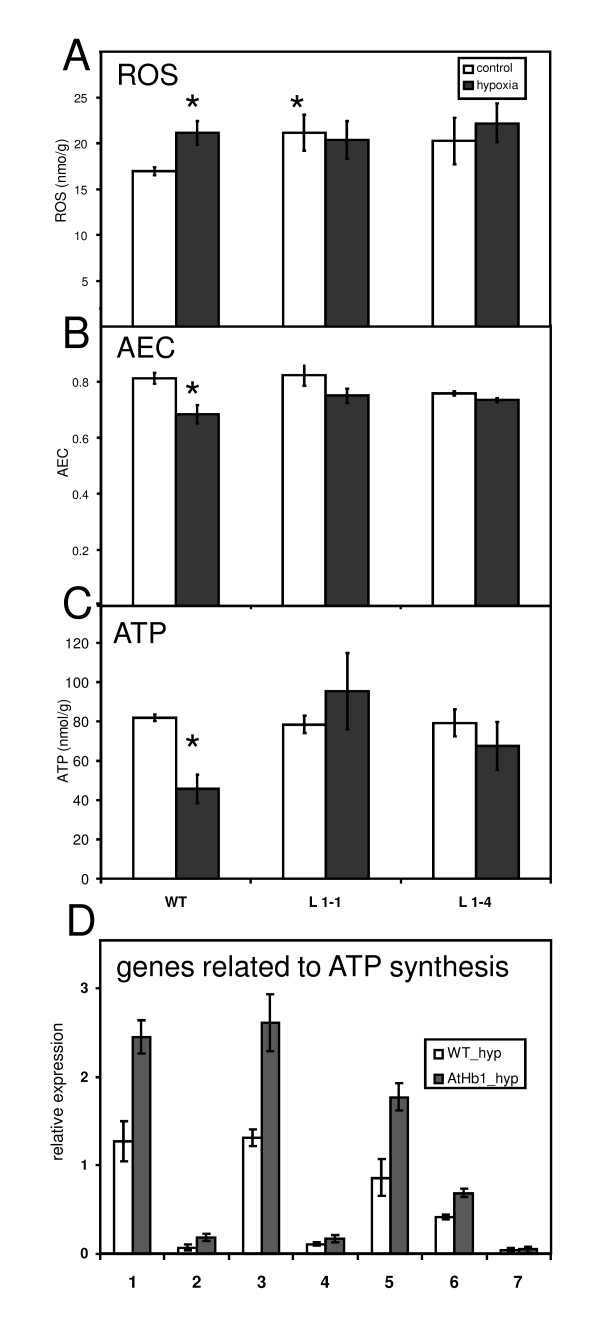
Effects of AtHb1 overexpression on energy metabolism of seeds. Plants were grown under control conditions and moderate hypoxia. (A) Levels of hydrogen peroxide (H2O2), (B) Adenylate energy charge (AEC) and (C) ATP levels. (D) Relative expression levels of genes involved in ATP synthesis quantified by qRT-PCR after hypoxic treatment. 1 - ATPase (At2g21870), 2 - ATPase (Chl) (At1g15700), 3 - NADH-DH (At5g47890), 4 - NADH:ubi (At5g18800), 5 - COX5C (At5g61310), 6 - COX5C (At3g62400), 7 - AOX1 (At1g32350). Mean values ± standard deviation are presented (n = 5); asterisks indicate statistical significant differences according to a student's t-test (p < 0.05, A-C).